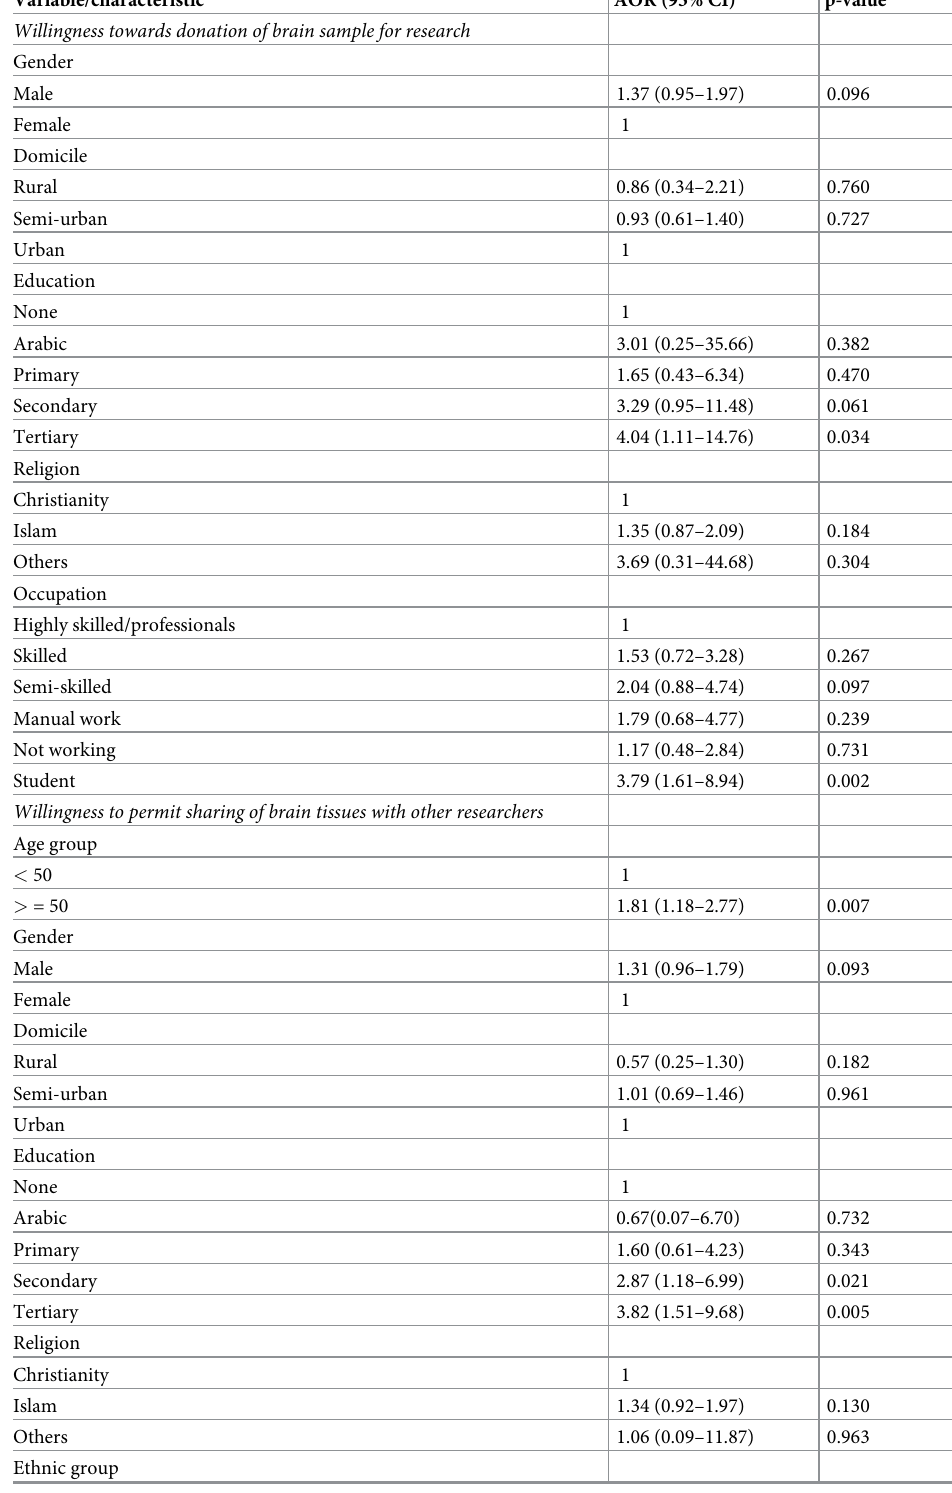
Table 6. Association of socio demographic characteristics and willingness to donate/share blood/brain